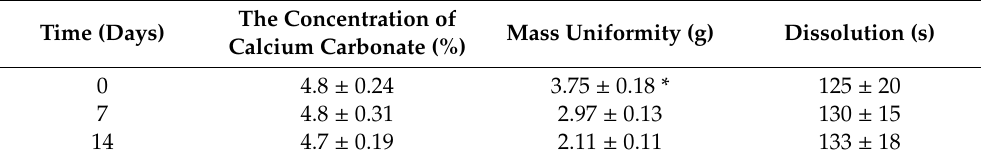
Table 5. Quality assessment of gummy bears containing calcium carbonate and vitamin D 3